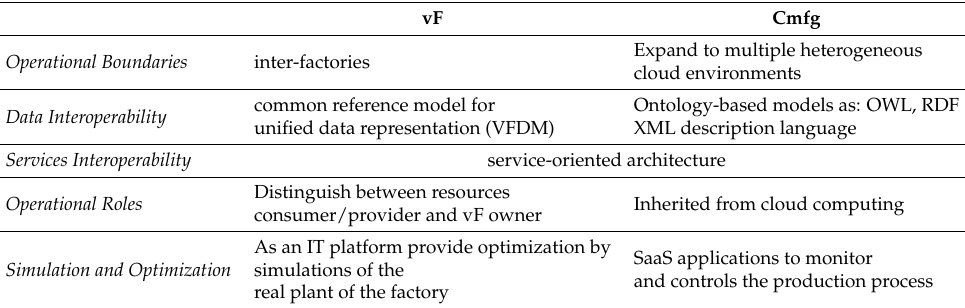
Table 2. Key features of vF and